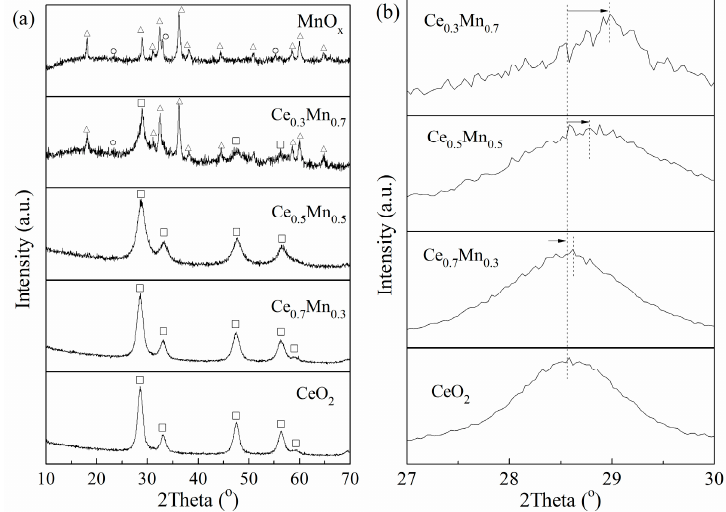
Figure 2. XRD patterns of all the samples: ( a ) wild angle patterns, and ( b ) Enlarged-zone patterns. Crystalline phases detected: ( o ) CeO 2 , ( □ ) Mn 3 O 4 , ( ∆ ) Mn 2 O 3 .